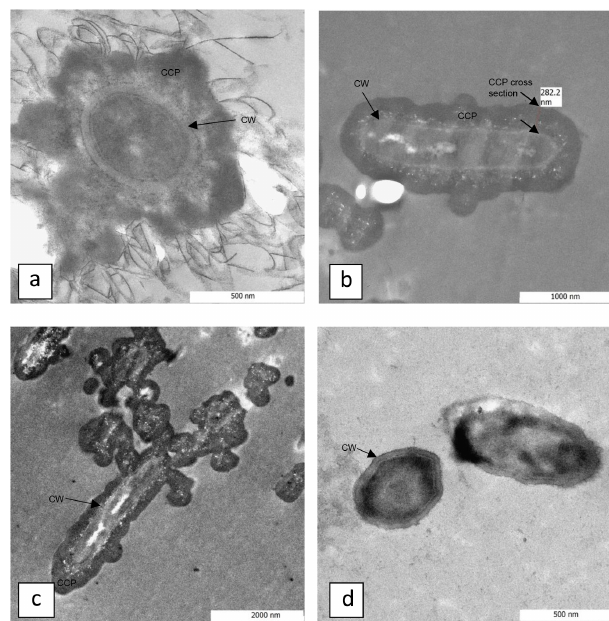
Figure 3. Transmission electron microscopy images of S. pasteurii cells in calcium-inclusive (a–c) and calcium-exclusive (d) media with cell walls (CWs) and calcium-containing precipitate (CCP) la- beled. Panels (a) and (d) show end cross sections though S. pasteurii cells, with CWs clearly exhibited. A calcium-containing precipitate coverage that encapsulates the cells is exhibited as darker regions beyond the cell wall in (a) – (c) . The labeled CCP cross section is measured in (b) and is approximately 280nm